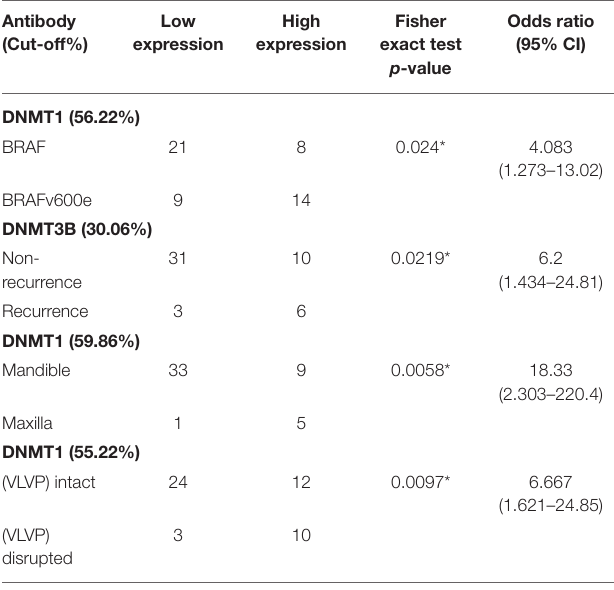
TABLE 3 | Contingency analyses (Fisher exact test) in significant variables using the cut-off point. Antibody